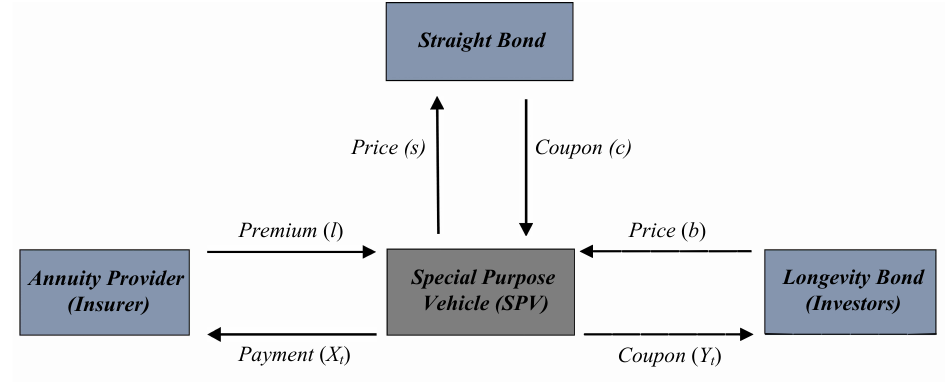
Figure 1. Transactions of the special purpose